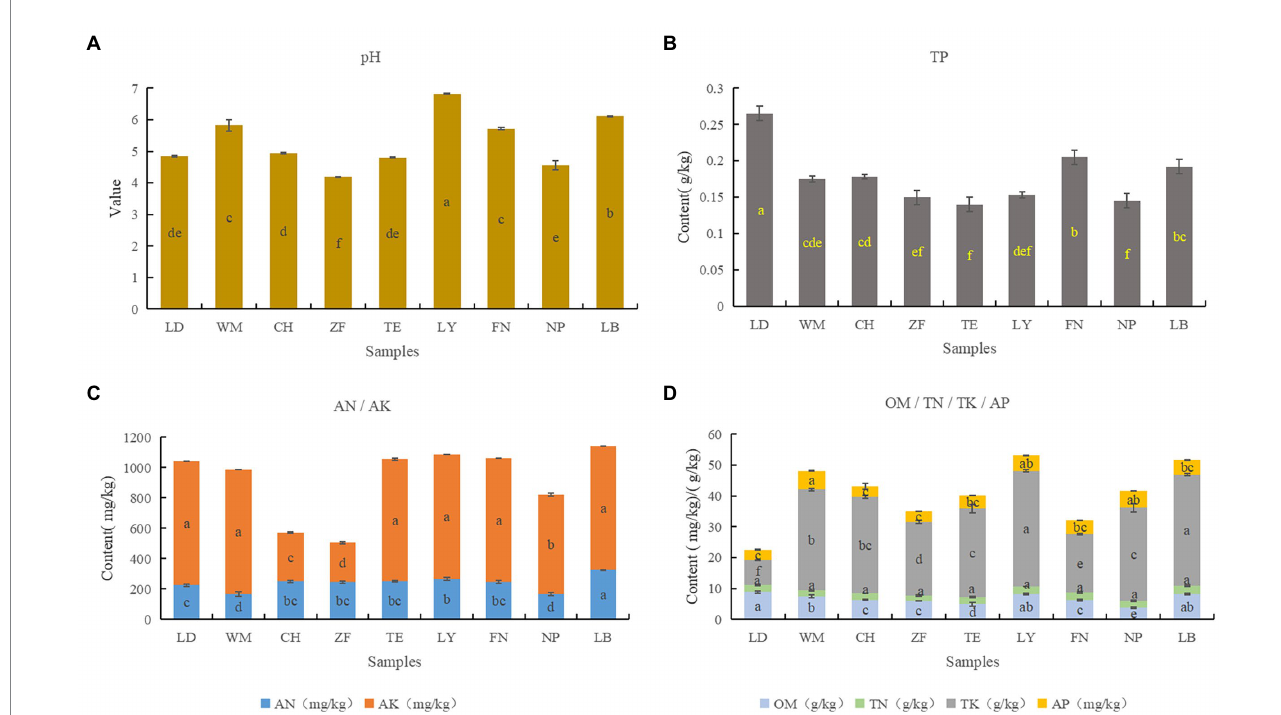
FIGURE 5 Nutrient and chemical properties of C. migao rhizosphere soils from nine sites. The ANOVA analysis and Turkey were used to compare the soil chemical properties across nine sample sites. Different letters indicate significant differences ( p < 0.05 ; n = 5). The color of the column represents the different soil chemical properties, and the length of the column represents the content of the soil chemical property. (A) PH, (B) the content of total phosphorus (TP), (C) contents of alkali hydrolyzed nitrogen (AN) and total potassium (TK), (D) contents of organic matter (OM), total nitrogen (TN), available phosphorus (AP), and available potassium (AK).